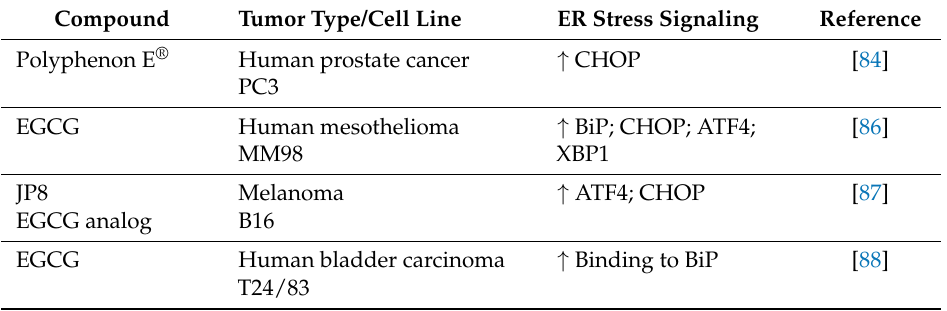
Table 3. Green tea polyphenols and its analogues with ER stress-mediated anticancer activity. Compound Tumor Type/Cell Line ER Stress Signaling